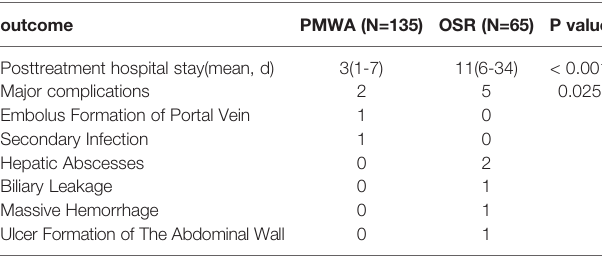
TABLE 5 | Major Complications and Hospital Stay after Treatment.